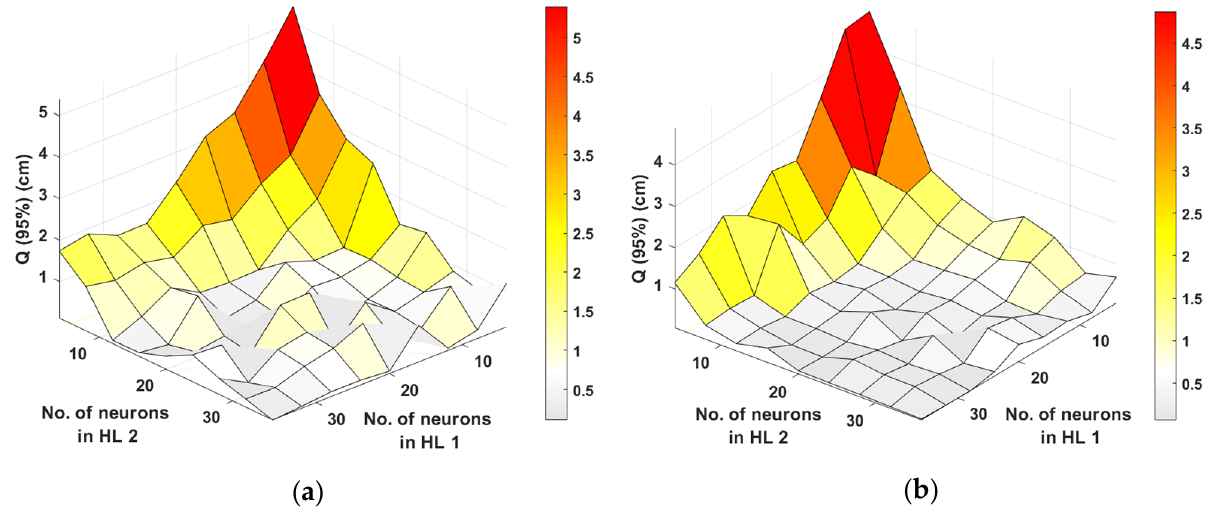
Figure 7. The ε p for the inner region for different training methods of ANN: ( a ) LM, and ( b ) BR. Table 4. Comparison of 𝜀 for different training algorithms. (cid:3043)(cid:2879)(cid:2923)(cid:2919)(cid:2924) Algorithms